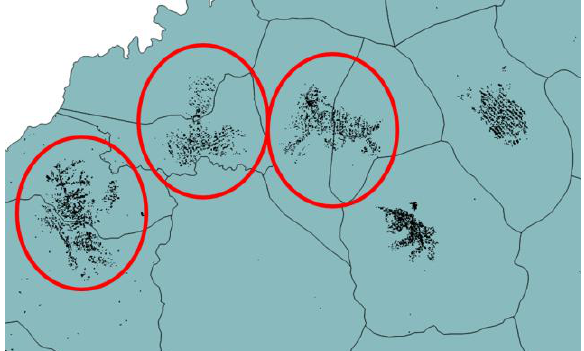
Figure 2. The red circles highlight cases where cross-border village structures are identified in contrast to detected villages solely within their administrative spatial extent.